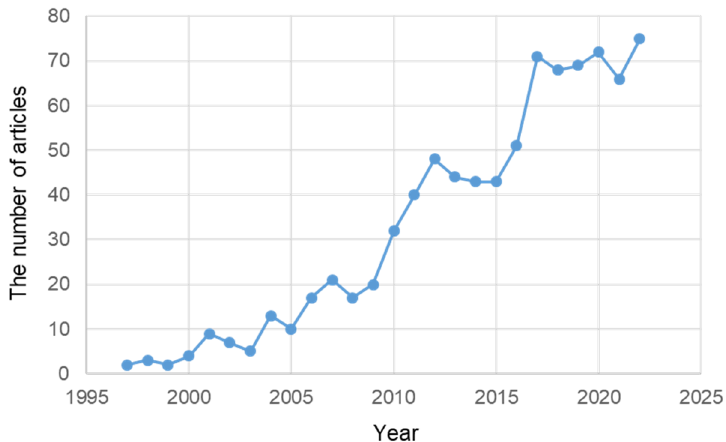
Figure 4. The number of articles related to ER stress in AD published in PubMed from 1997 to 23 November 2022.